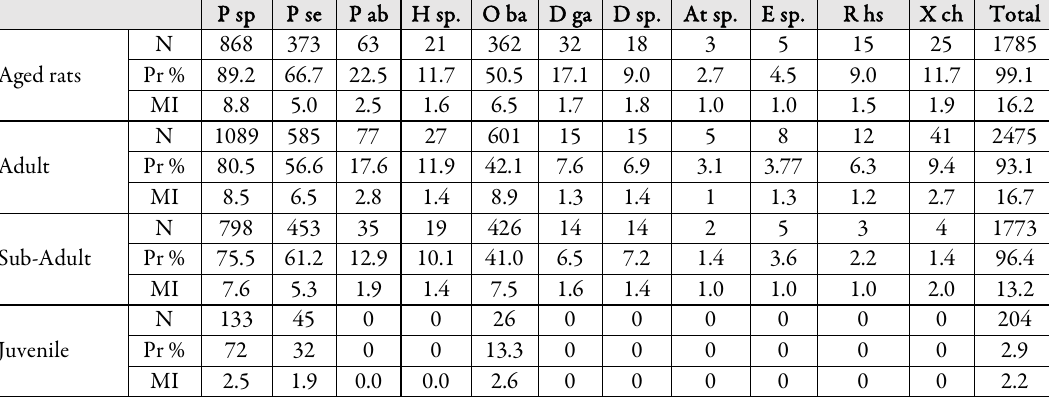
Table 2. Prevalence (Pr %) and mean intensity (MI) of R. rattus ectoparasites depending on age